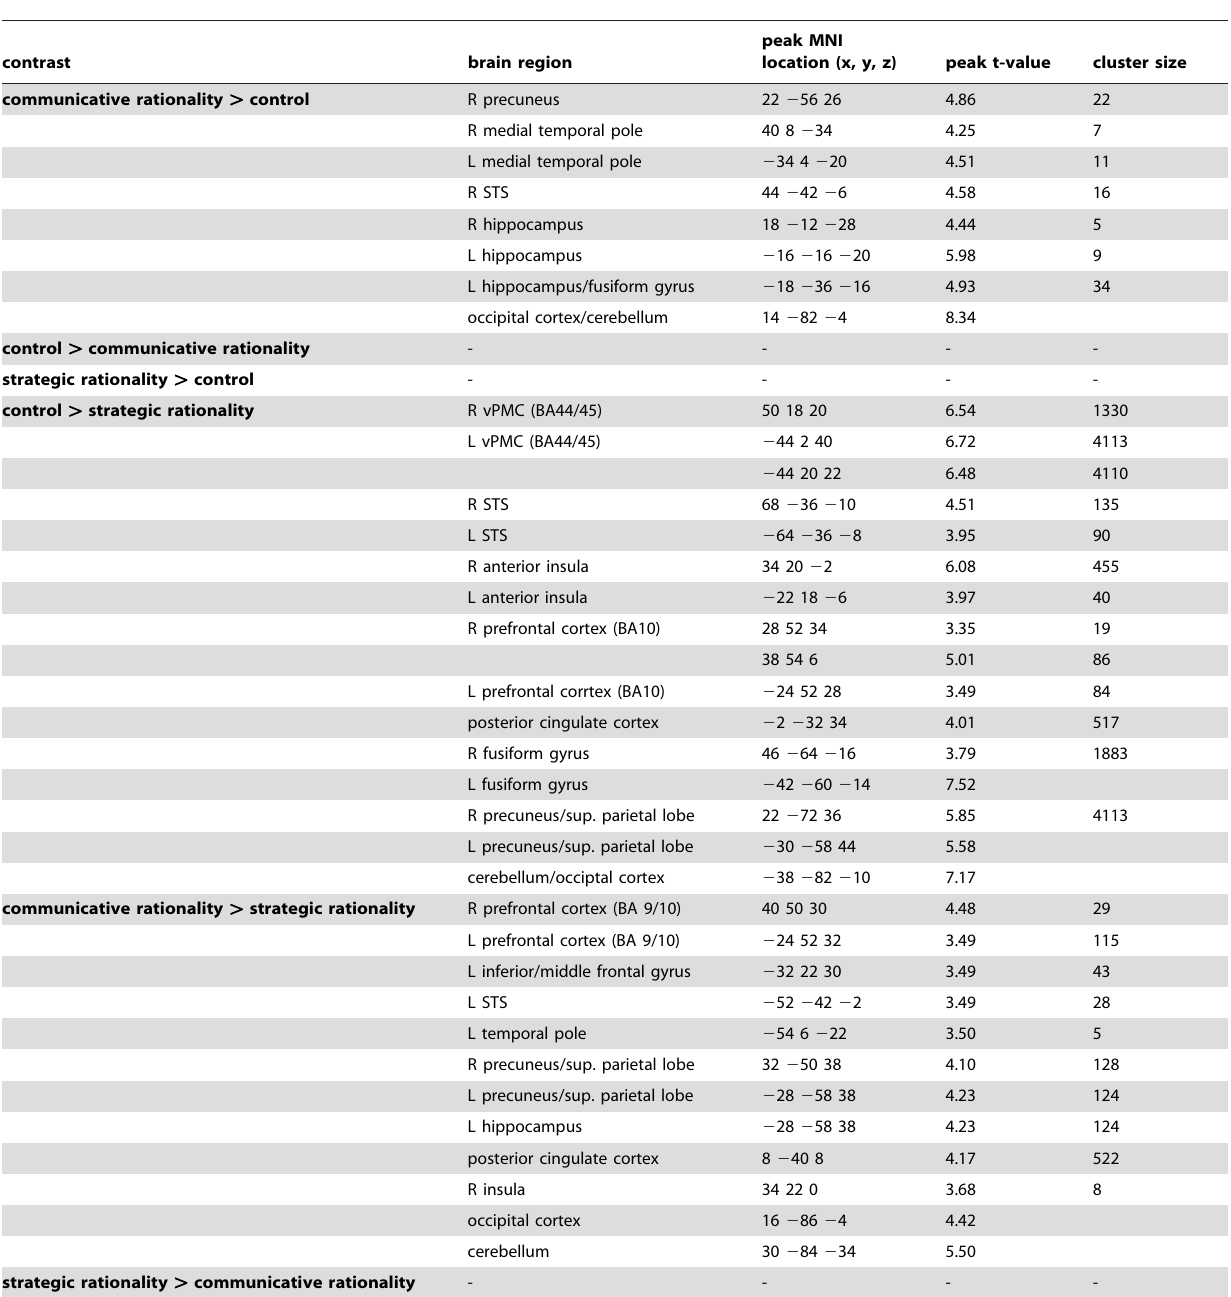
Table 1. Results of random effects analysis (at p , 0.05, FDR corrected, L =left hemisphere, R=right hemisphere, sup =superior).